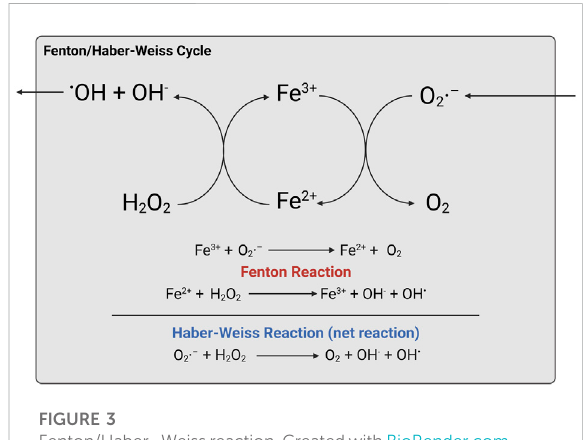
FIGURE 3 Fenton/Haber – Weissreaction.Createdwith